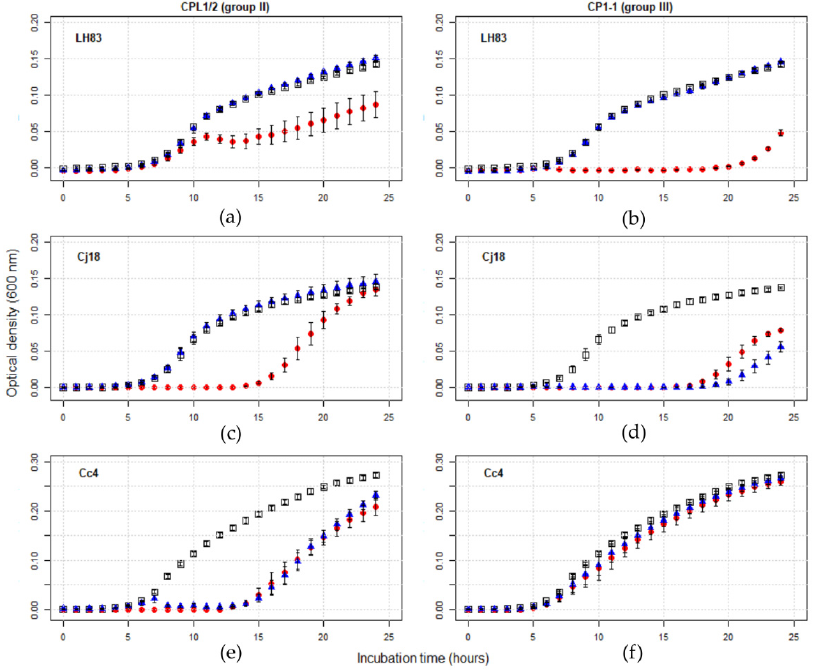
Figure 3. Exemplary growth curve comparison of Campylobacter alone and in presence of two phage concentrations. PKA experiments were performed in a Tecan Spark Microplate Reader. Optical density was measured every hour at 600 nm for 24 h. Curves represent mean OD 600 values of three or four experiments, with error bars indicating standard error of the mean. Control curves ( □ ) and PKA curves for MOI input 10 ( ● ) and 0.001 ( ▲ ) are displayed. The observed effects of phages on bacterial population growth could be classified into three groups: either no effect at all (e.g., Cc4 + CP1-1 ( f )), limited growth impediment at a high MOI input only (e.g., LH83 + CPL1/2 ( a ) or + CP1-1 ( b ), Cj18 + CPL1/2 ( c ), and Cc4 + CPL1/2 ( d )), or growth was impeded at both a high and low MOI input (e.g., Cc4 + CPLVL1/2 ( e )).